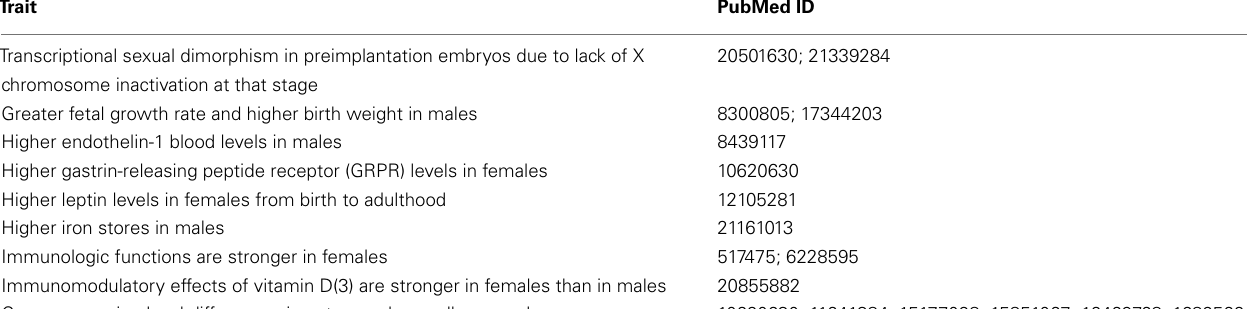
Table 3 | Physiologic and genomic differences between males and females that may be relevant to differential cancer susceptibility.